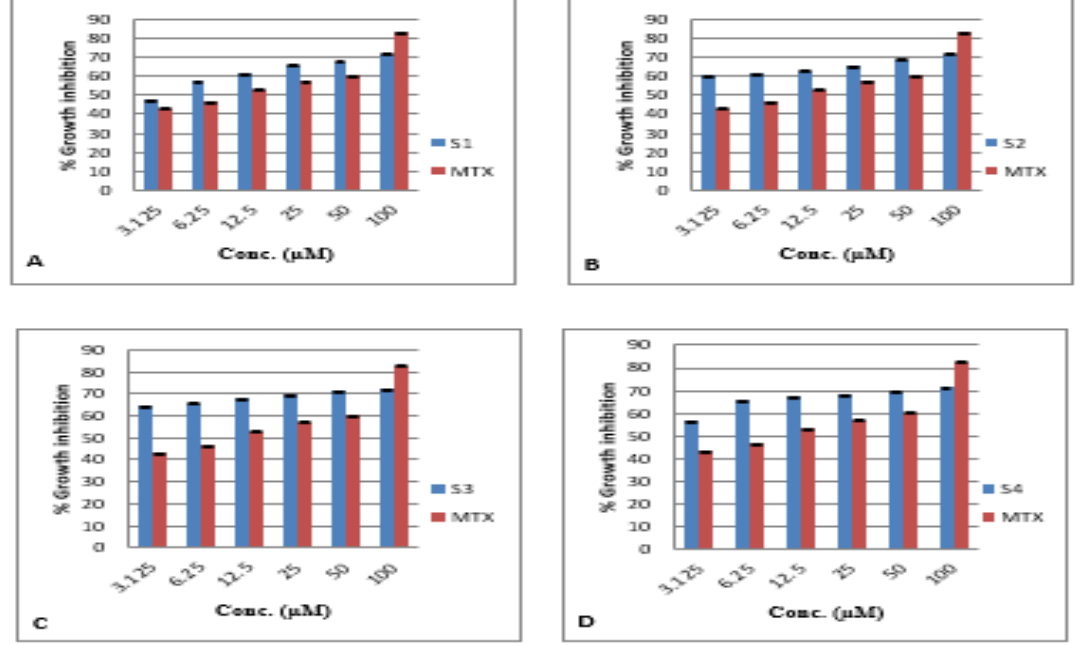
Figure 4 . Histogram showing the concentration (µM) versus growth inhibition of the tested compounds: Compound S1 ( A ), Compound S2 ( B ), Compound S3 ( C ), and Compound S4 ( D ) against breast carcinoma cell line (MCF-7). (Values are represented by the mean ± SEM of triplicate